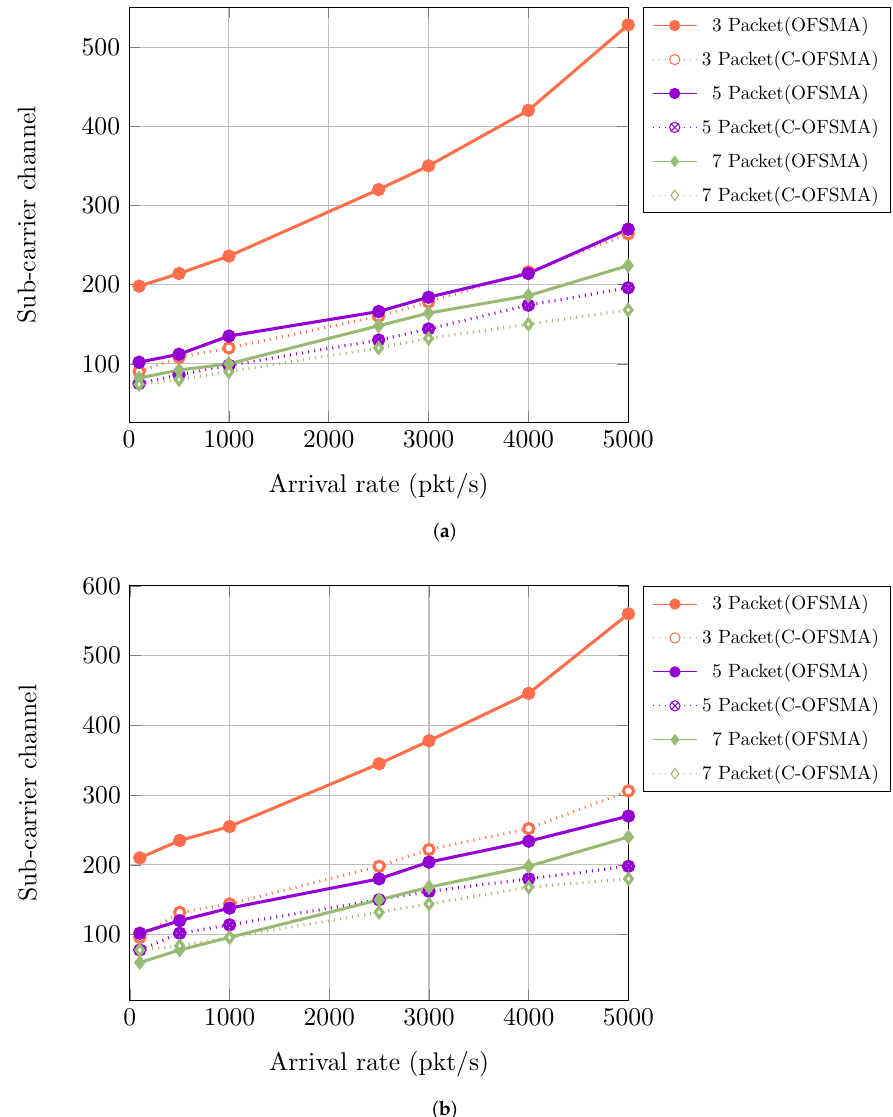
Figure 6. Determine minimum subcarrier channels to satisfy URLLC’s reliability 99.999% for 3-, 5-, and 7-packet duplication. ( a ) Mathematical, ( b )